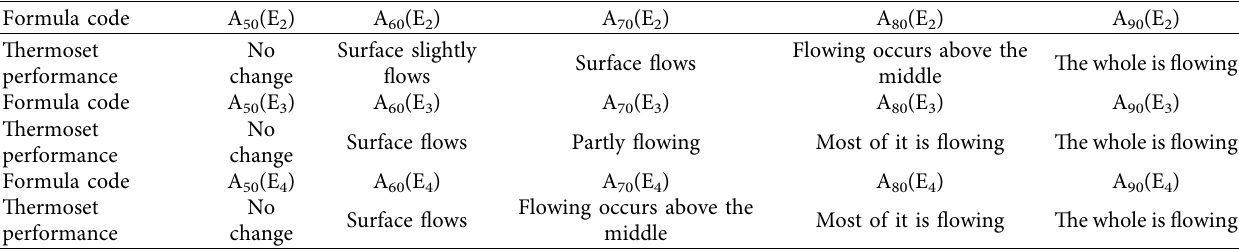
Table 6: Thermosetting grade of cured product.